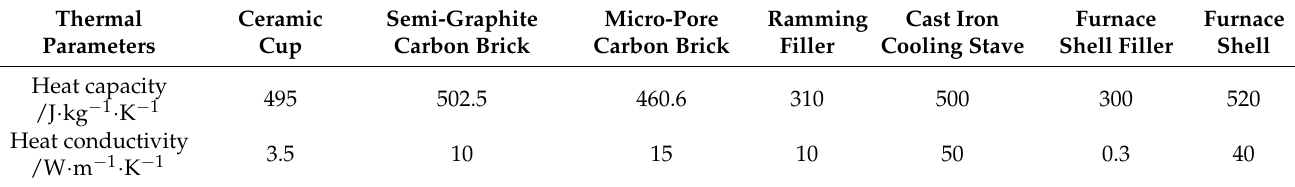
Table 5. Main thermal parameters of refractory